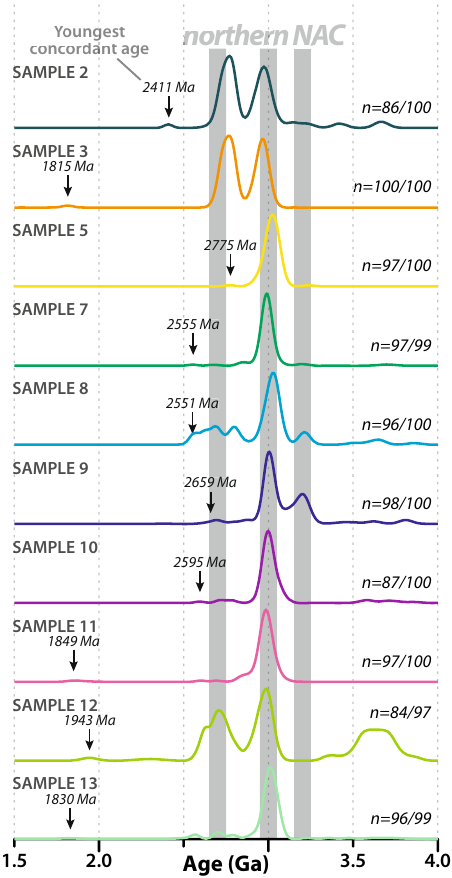
Fig. 3 Probability density diagrams of zircon U-Pb dates. Stacked probability density diagrams of zircon dates from stream sediment samples in the northern North Atlantic Craton. All ages are 207 Pb/ 206 Pb and <10% discordant. The number of analyses within concordant limits versus all analyses is denoted with ‘ n ’ . The major age peaks for magmatic rocks in the northern NAC are indicated by gray vertical bars. Source data information for this fi gure is provided in Supplementary Data 1. mechanism to source >3.2 Ga zircon crystals is to incorporate them as either xenocrysts or from xenoliths in later magmas that assimilated this material on transit through the basement.